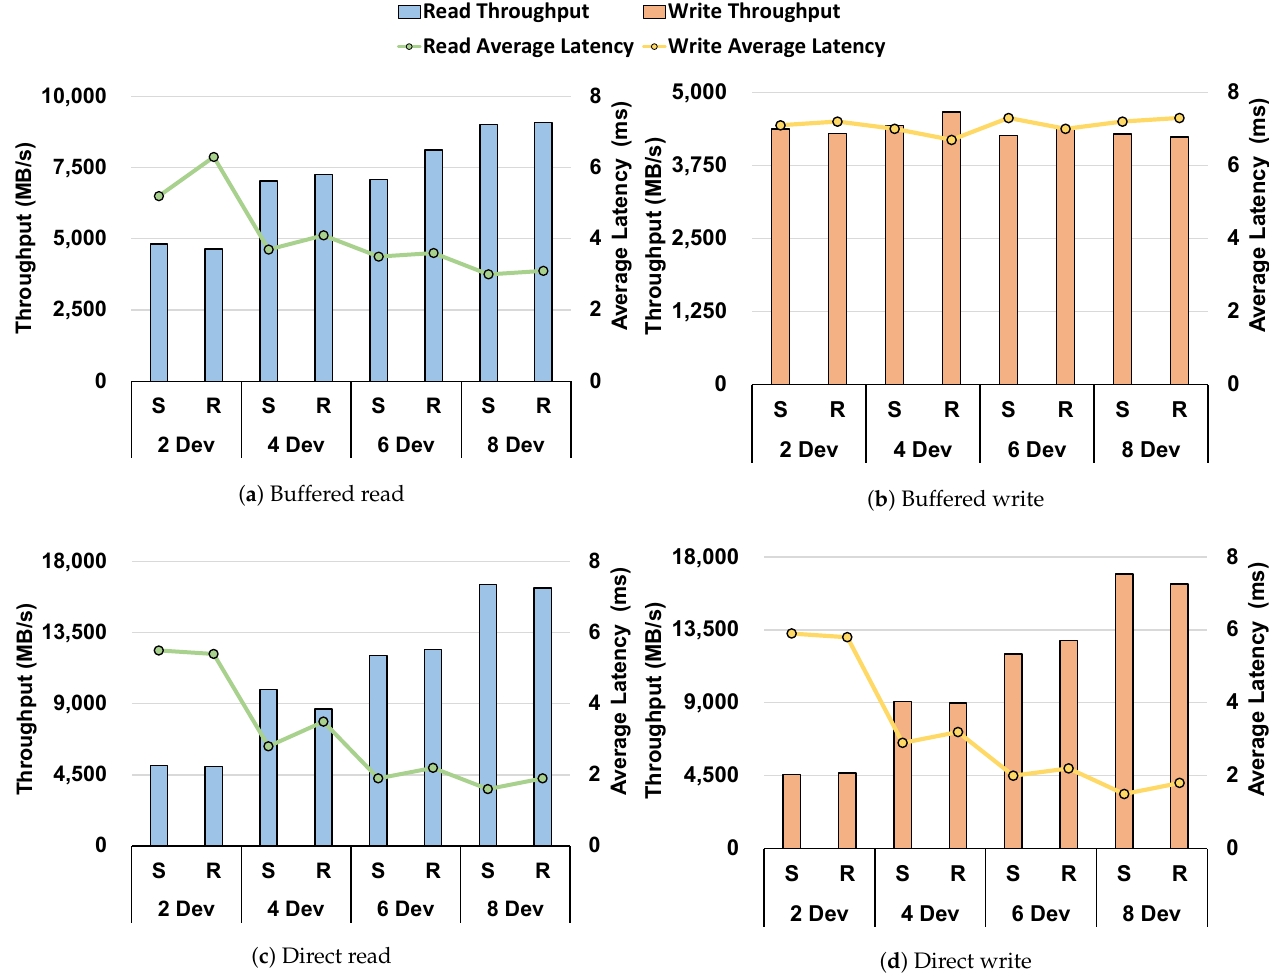
Figure 1. Experimental results under RAID 0 (S: sequential, R: random, Dev: number of